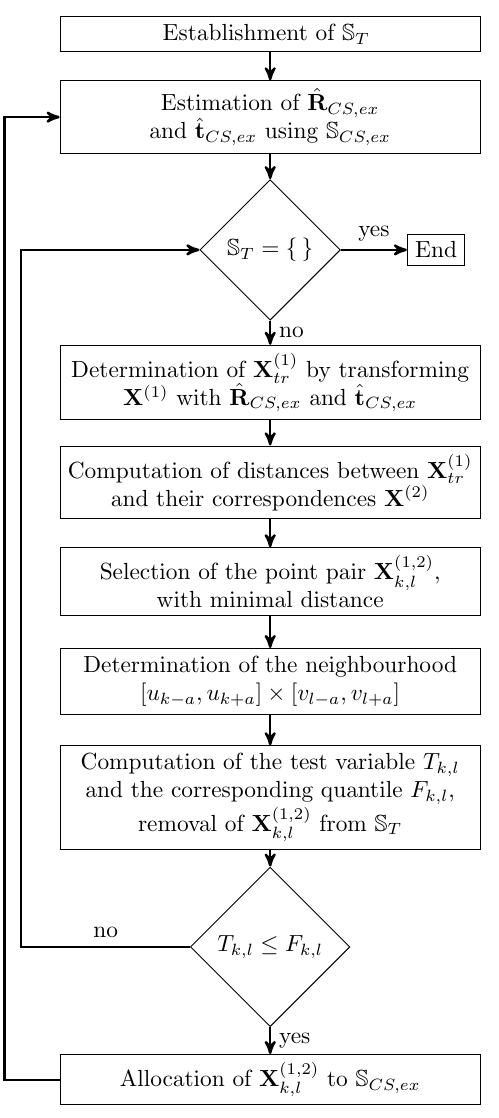
Figure 6. Flow chart of the localisation of distorted regions [30]. The scanning process of this object during the first measuring epoch E 1 is emu- lated by regularly sampling the B-spline surface along the parameter lines, resulting in 10,000 surface points with a spatial resolution of 4–5 mm. Afterwards, the surface points are superimposed by normally distributed measuring noise n the VCM of the measuring noise. In these initial studies, the measuring noise is modelled to be uncorrelated, with a standard deviation of σ n these specific values characterising the data points’ precision leads to an average point error of 1 mm